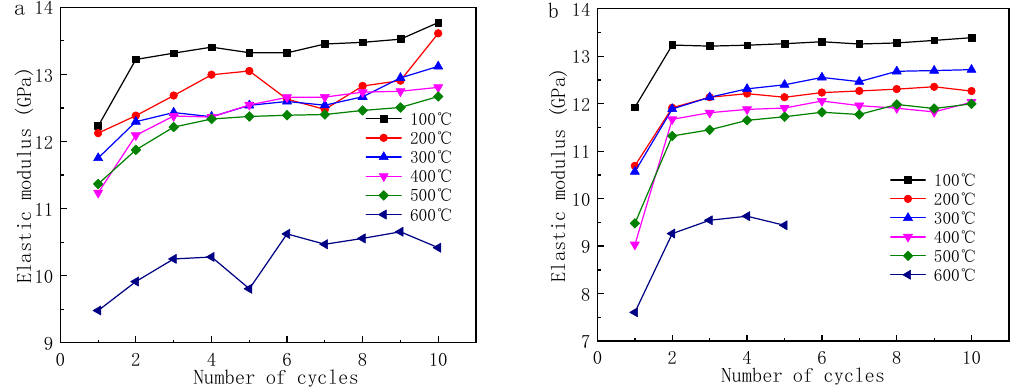
Figure 6. Variations of elastic modulus of granite samples with number of temperature and stress cycles at six upper limit cyclic temperatures ( a ) upper limit of cyclic stress = 70% of UCS, ( b ) upper limit of cyclic stress = 85% of UCS.